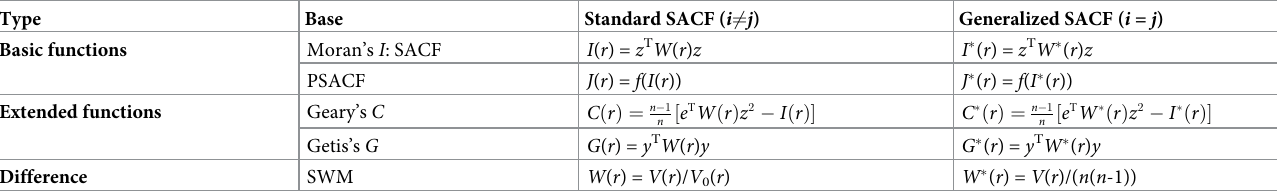
Table 5. Collections of two types of spatial autocorrelation functions and the extended